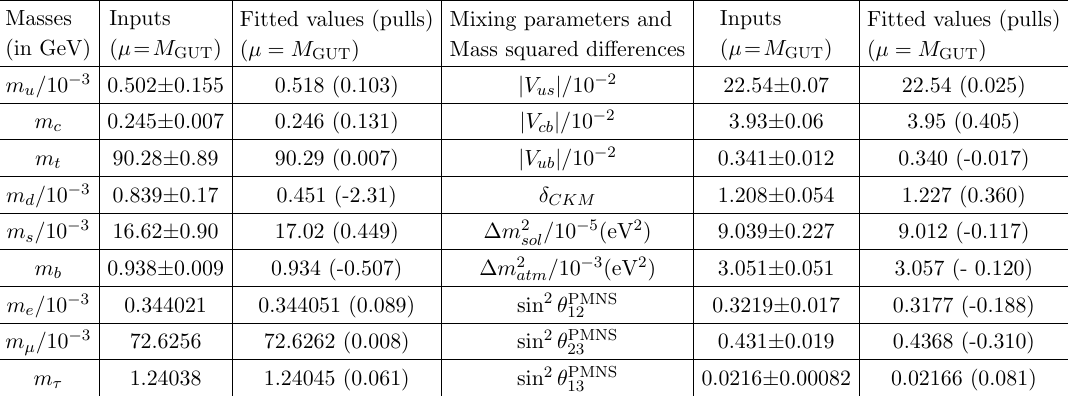
Table 5 . Best (cid:12)t values of the observables corresponding to the type-I dominance seesaw scenarios for tan (cid:12) = 10. This best (cid:12)t corresponds to total (cid:31) 2 = 6 : 3. For the associated 1 (cid:27) uncertainties of the observables at the GUT scale, we keep the same percentage uncertainty with respect to the central value of each quantity as that at the M Z scale. For the charged lepton Yukawa couplings at the GUT scale, a relative uncertainty of 0 : 1% is assumed in order to take into account the theoretical uncertainties arising for example from threshold e(cid:11)ects.